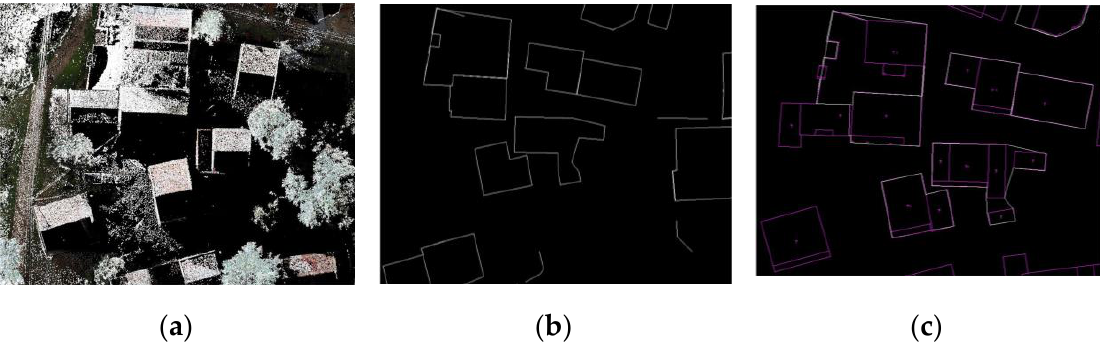
Figure 8. ( a ) A close-up view of fused points; ( b ) extracted building contours (white); and ( c ) an overlay of the extracted and vector mapping reference (purple).